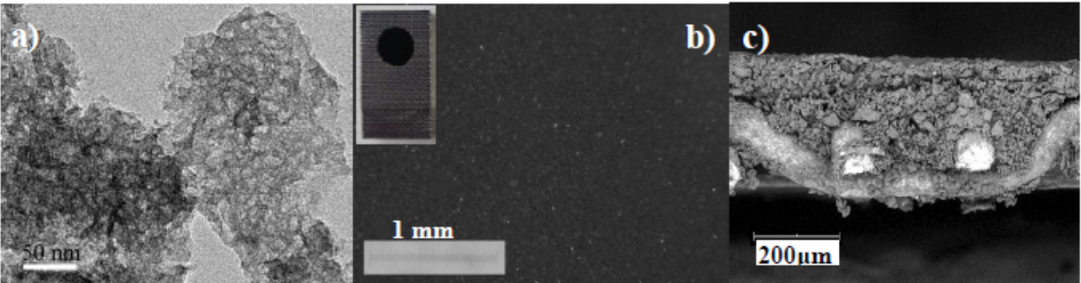
Figure 4. MC material and derivative MC/Ti CEs. ( a ) Representative transmission electron microscopy (TEM) image, ( b ) top view image of the front side of a MC-4/Ti CE with the photograph in the inset, ( c ) scanning electron microscope (SEM) image of cross-section of MC-4/Ti CE [31]. (Reproduced from Ref. [31], 10.1021/acs.jpclett.6b01356, with permission.) Table 1. Summary of the highest performing QD-SSCs reported that use C-based electrodes. CE